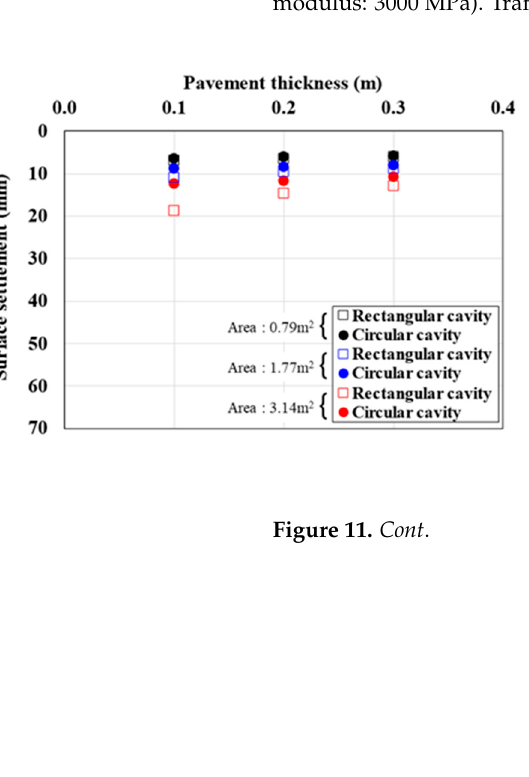
Figure 10. Surface settlement according to pavement thickness by cavity area (pavement elastic modulus: 3000 MPa). Traffic load: ( a ) 12.7, ( b ) 25.4, and ( c ) 38.1.